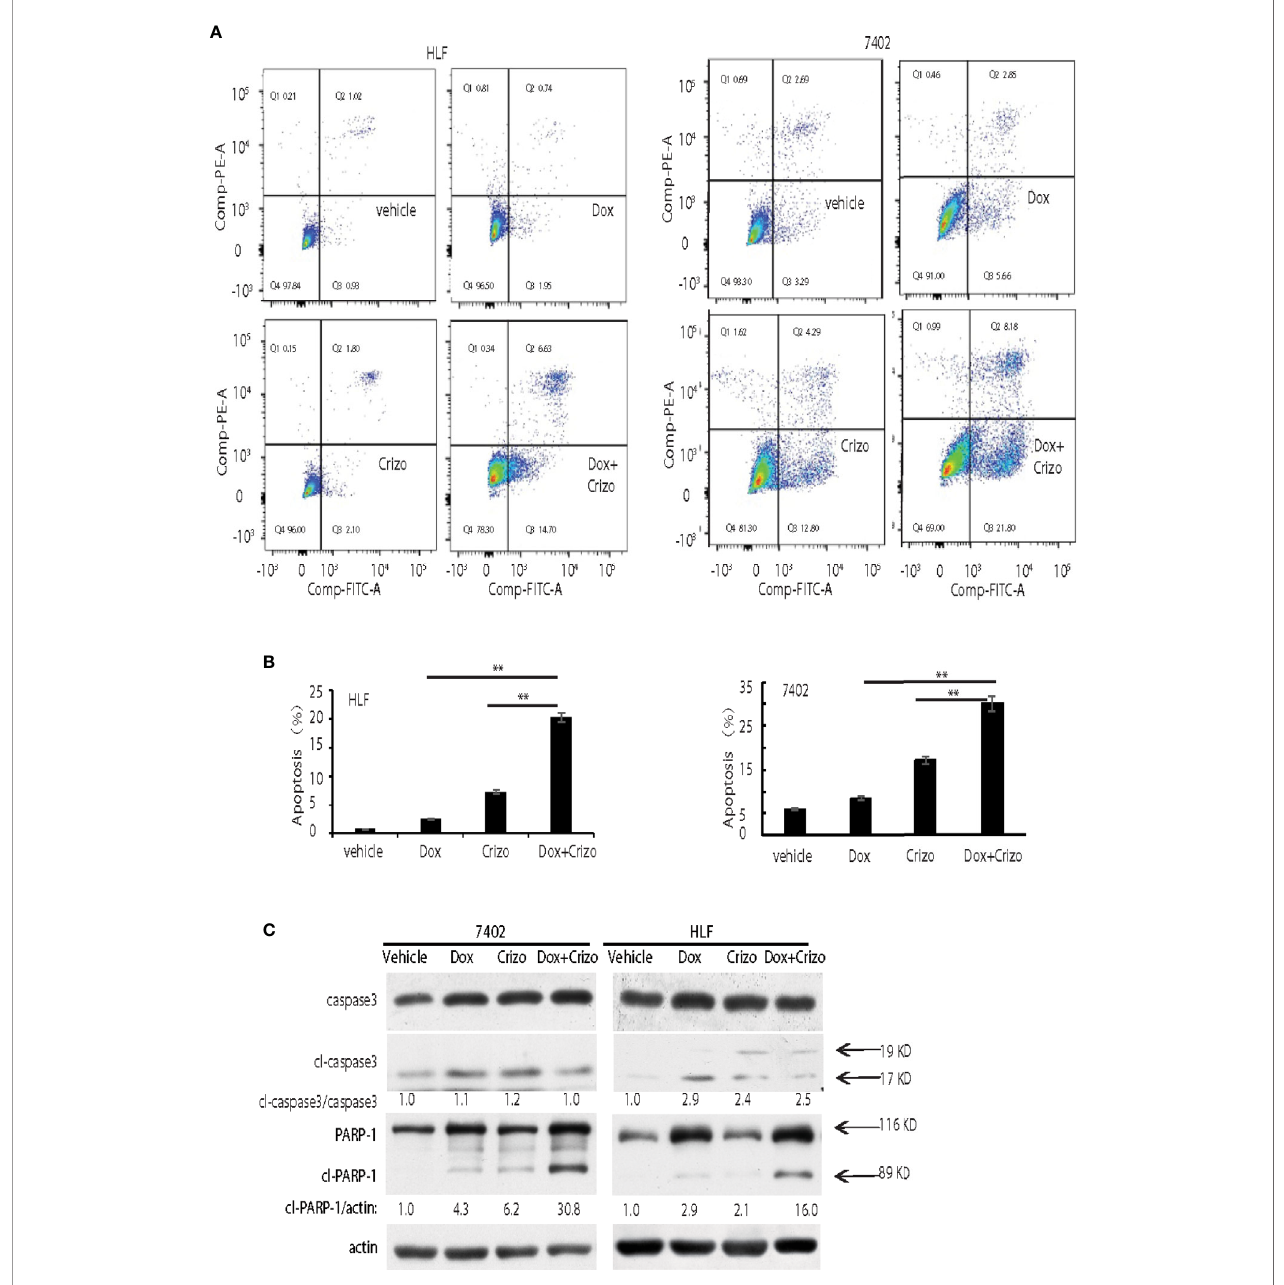
FIGURE 2 | Crizo plus Dox show a synergistic effect in killing cancer cells by inducing PARP-1 cleavage. (A) Crizo (5 m M) plus Dox (0.85 m M) induced signi fi cantly more cell apoptosis compared to vehicle, Dox (0.85 m M), or Crizo (5 m M) only. Flow cytometry assays of HLF and 7402 cells showed that Crizo plus Dox treatment on these cells activated obviously more early and later apoptosis (Q3 and Q2) when compared to HCC cells treated only with vehicle, Dox, or Crizo. (B) Statistical analysis of three different experiments showed that Crizo plus Dox induced signi fi cantly more apoptosis than Dox or Crizo only on HCC cells. Percentage of apoptosis was de fi ned as the combination of early and later apoptosis (Q2+Q3) (Filled in bar graph represented the mean and standard deviation). (C) Crizo plus Dox induced more cleaved PARP-1 compared to vehicle, Dox, or Crizo only when treating HCC cells. Immunoblotting of cell lysates from 7402, HLF were treated with vehicle, Dox (0.85 m M), Crizo (5 m M), or Dox (0.85 m M) plus Crizo (5 m M) with PARP-1 and caspase-3 speci fi c antibodies showed more cleaved PARP-1 (cl- PARP-1) from cell lysates treated with Crizo plus Dox. In contrast, active caspase-3 (cl-caspase-3) was not signi fi cantly increased by Dox plus Crizo treatment. Cell treatment was performed the same as in Figure 1 . Relative protein levels were determined with IMAGE J as speci fi ed. The experiments were repeated at least three times with similar results. **P <